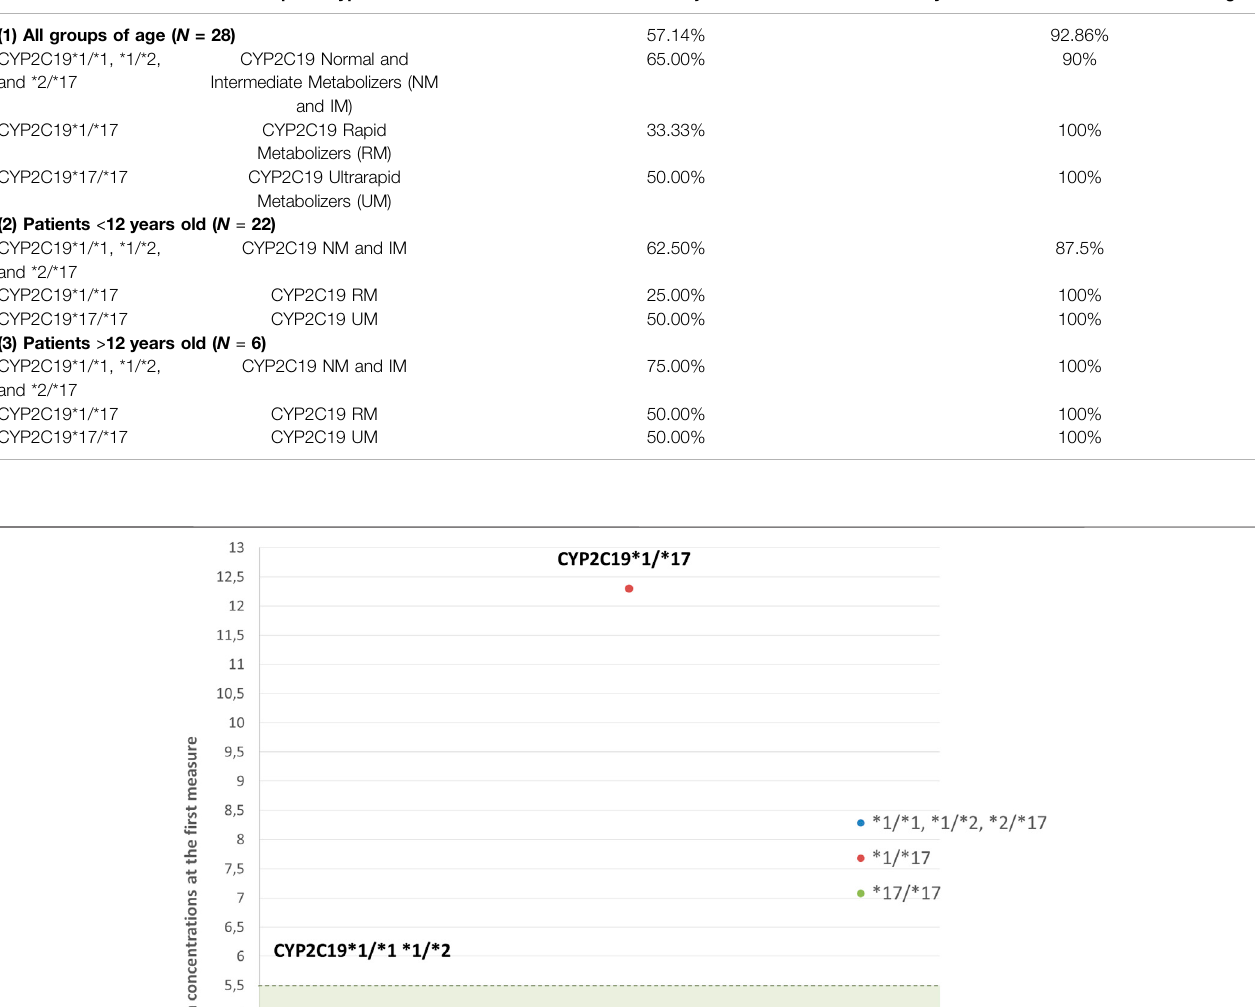
Frontiers in Pharmacology |